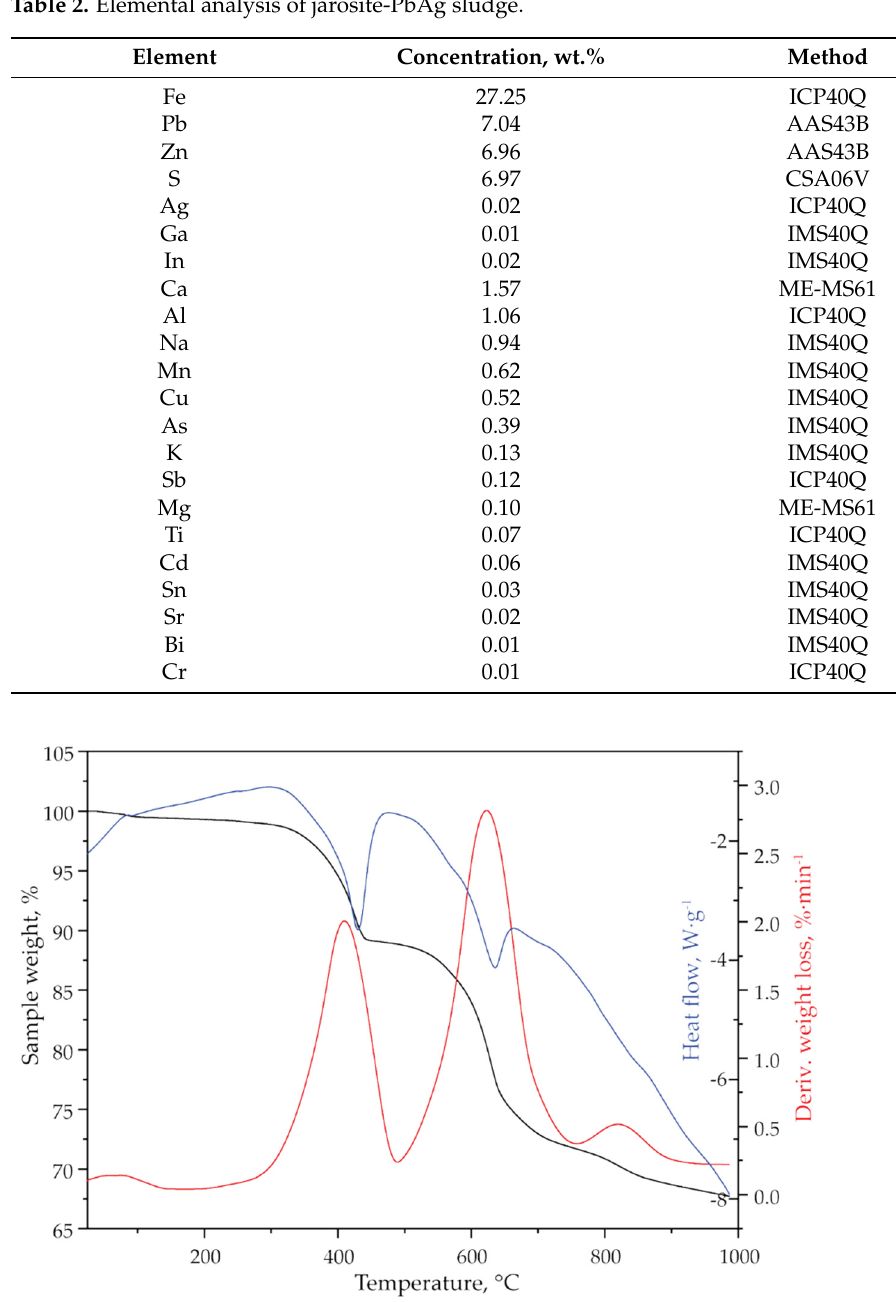
Figure 3. TG (black line), DTG (red line), and DSC (blue line) curves of jarosite-PbAg sludge.